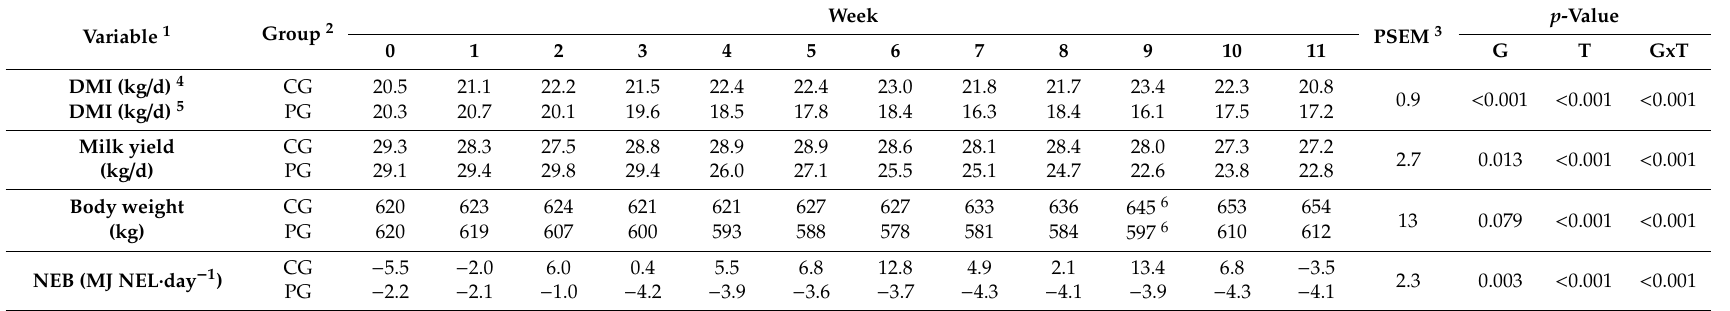
Table 2. E ff ect of a ration change from total mixed ration (TMR) to pasture combined with concentrate supply on animal performance. Variable